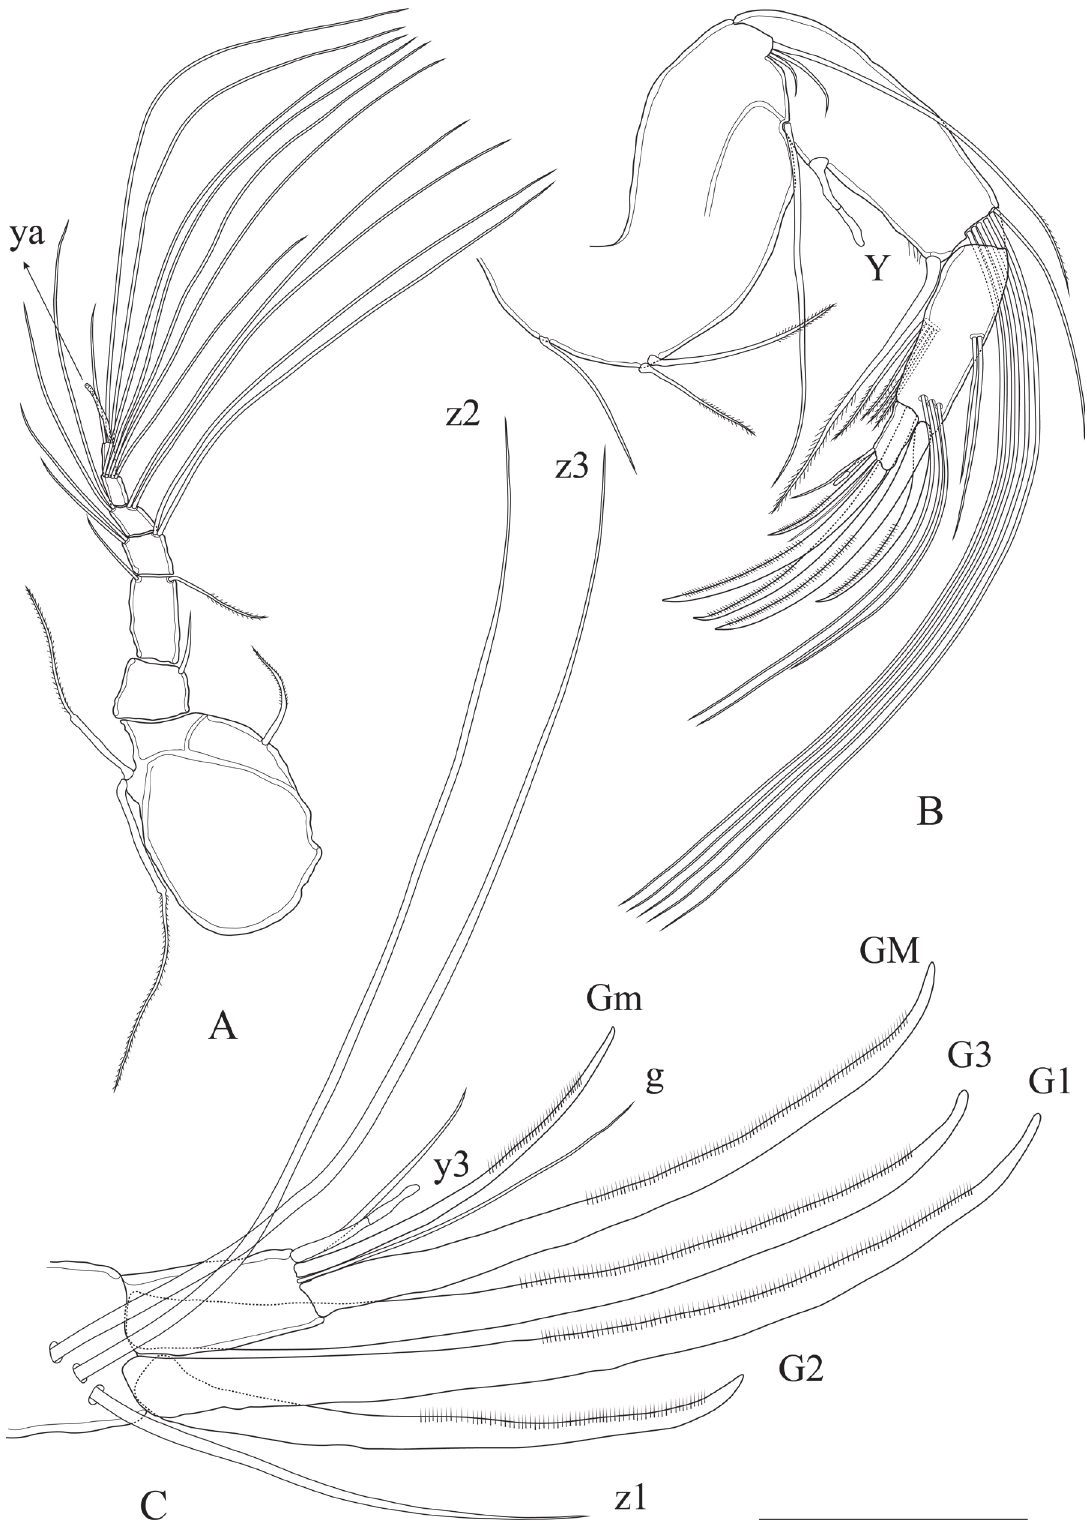
Fig. 4. Cyprinotus drubea sp. nov., ♀♀. A . A1 (MNHN-IU-2019-2542). B . A2 (MNHN-IU-2019-2541). C . Detail of apical chaetotaxy of A2 (MNHN-IU-2019-2542). Scale bar: A = 344 µm; B = 135 µm; C = 46